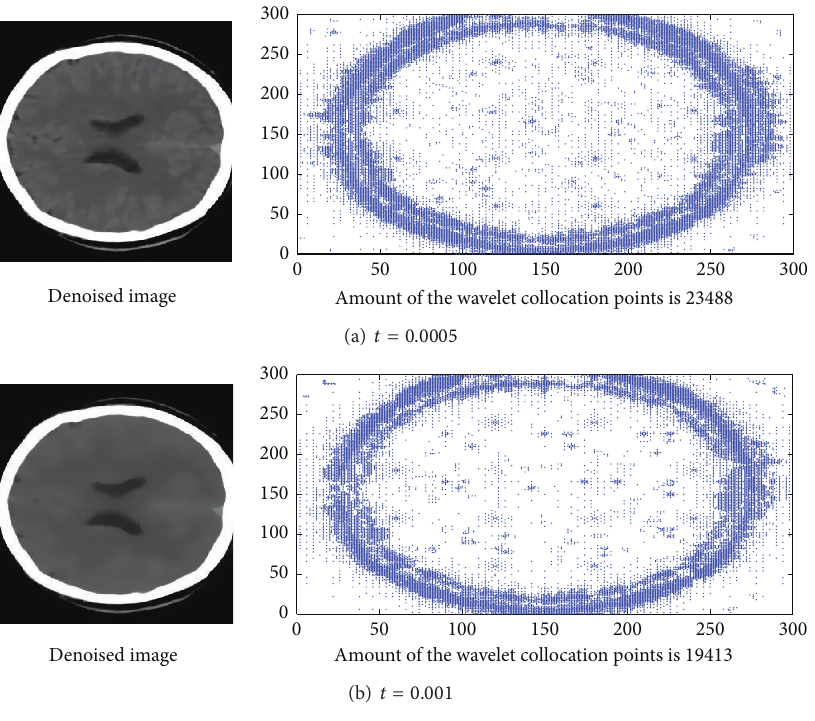
Figure 4: Adaptability of the multiscale sparse grid approach in image denoising (time step 𝜏 = 0.00001 ).